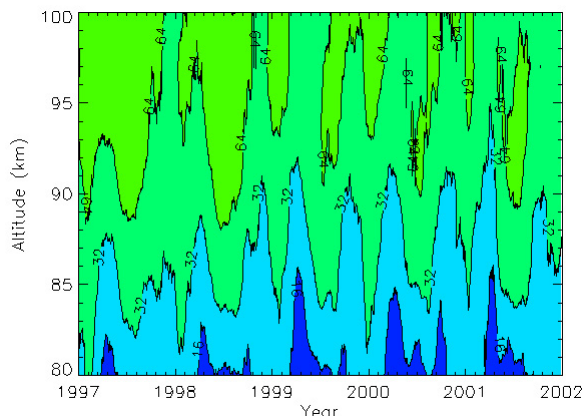
Fig. 1. Energy dissipation rate at the buoyancy scale, ε 0 (see text for details), as a function of time and height. The data shown here are the basis data set for the subsequent spectral analysis. Note that the heights, as for all figures, are virtual heights (see